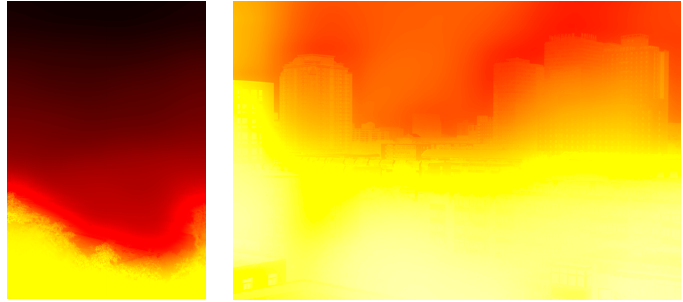
Figure 12. The corresponding images that are recovered via the refined transmission map t final . ( a ): The recovered image for the hazy image of Figure 9a. ( b ): The recovered image for the hazy image of Figure 9b.